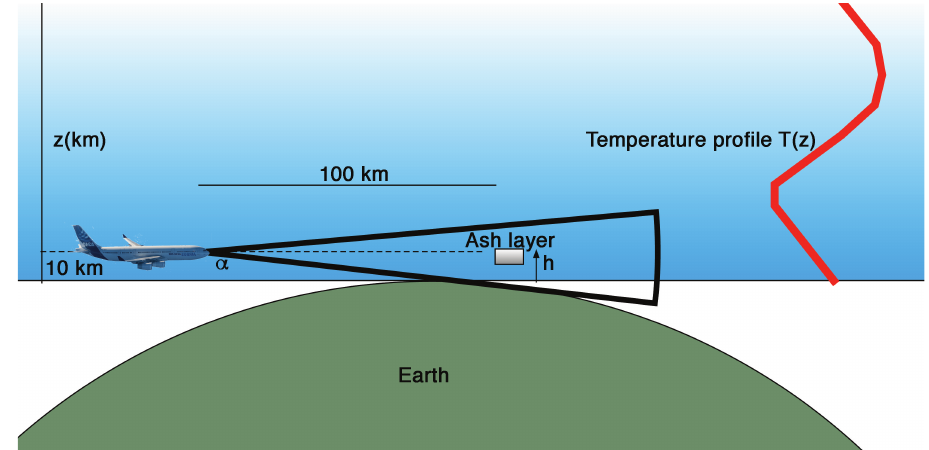
Figure 7. Schematic showing an airborne instrument viewing ahead of the aircraft. A wide horizontal field of view is useful but the important view is along the limb, indicated by the dashed line. It is preferable to have a restricted vertical field of view.